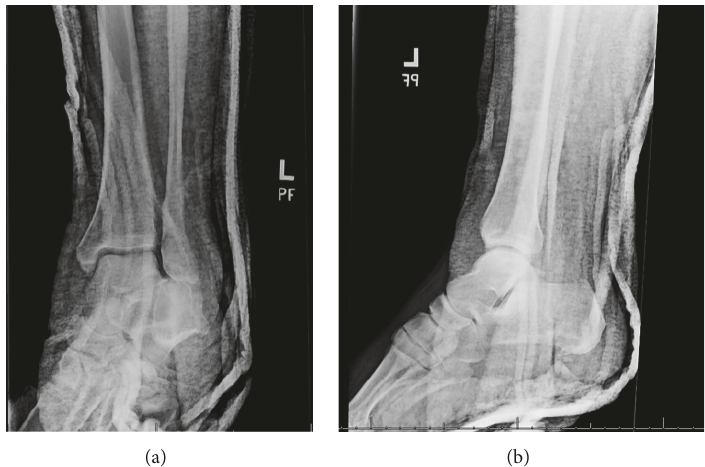
Figure 2: Postreduction radiographs demonstrating congruent reduction of the subtalar